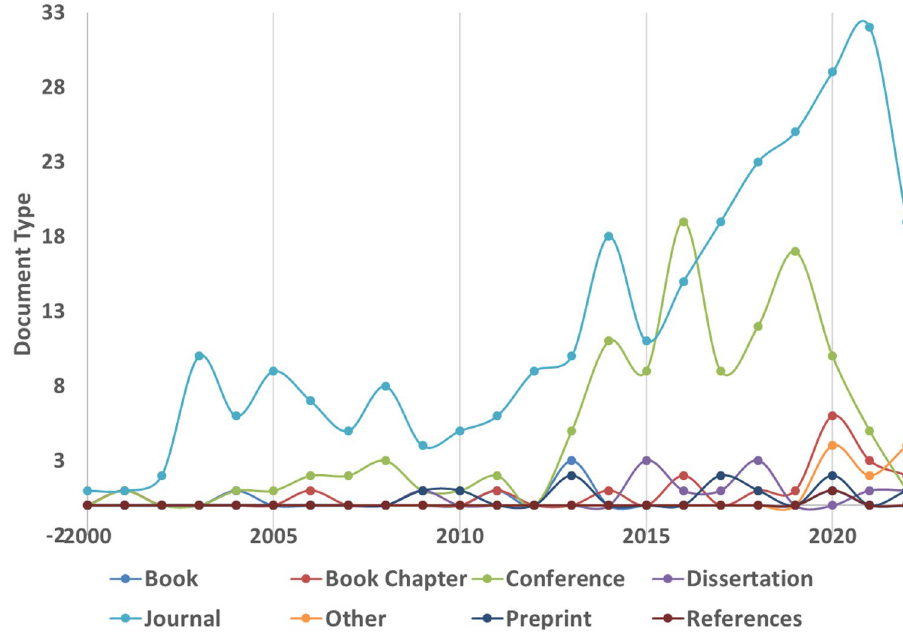
Fig. 1 Trend of publication on dust-fall and soiling effect in PV since 2000. Data obtained from lens.org, search keyword: “solar soiling